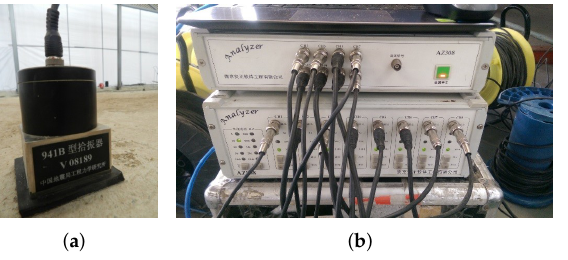
Figure 1. Instrument installation schematic. ( a ) Vibration pickup; ( b ) Analyzer System